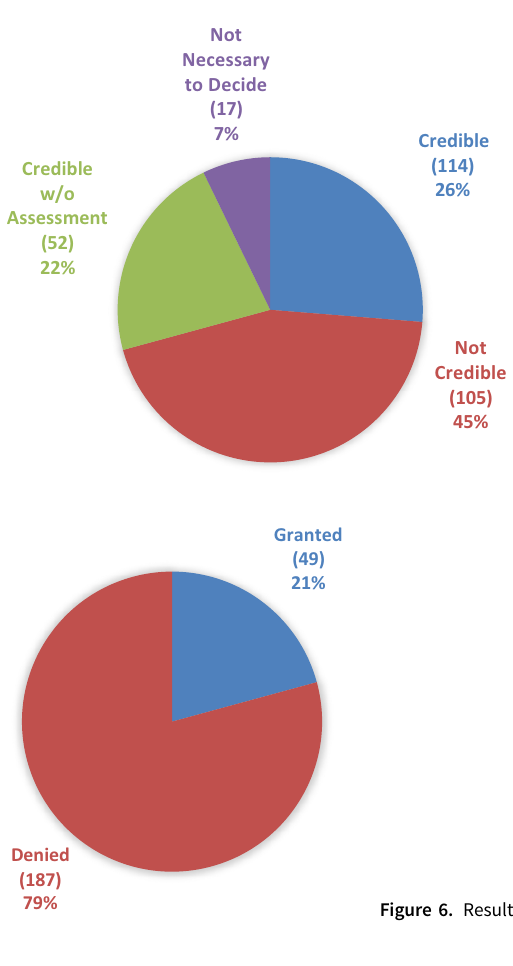
Figure 6. Results of Refugee Status